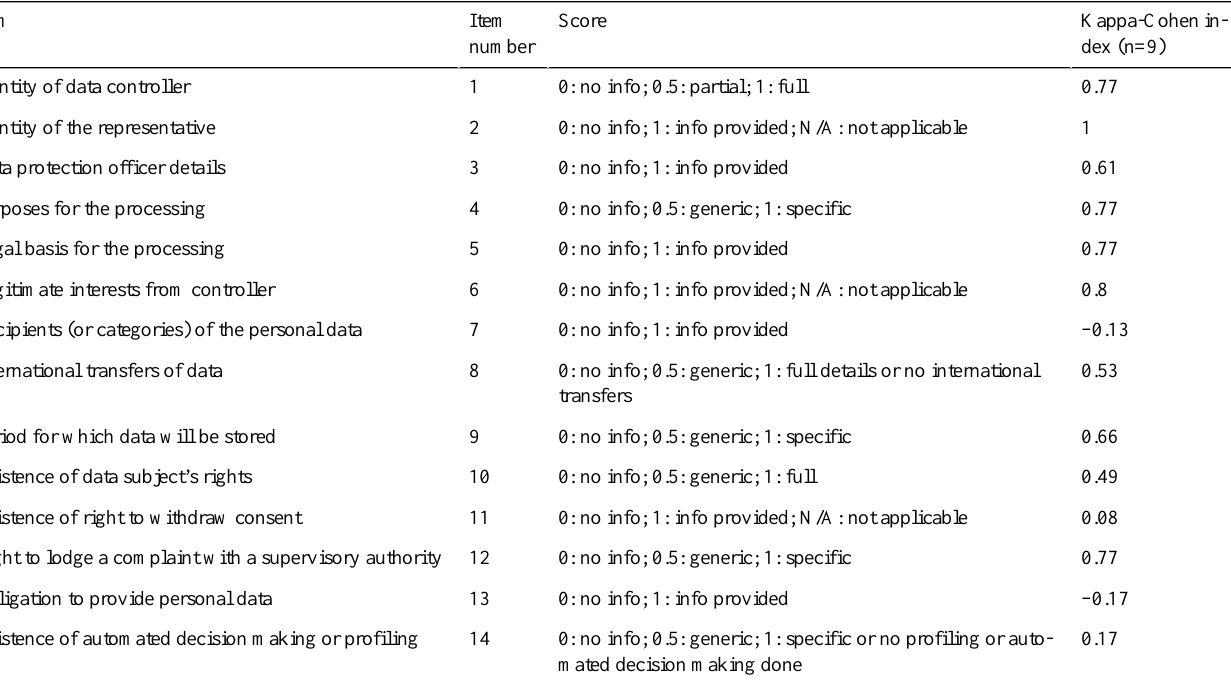
Table 3. Kappa-Cohen indexes for privacy policy items for the 9 apps evaluated in the first